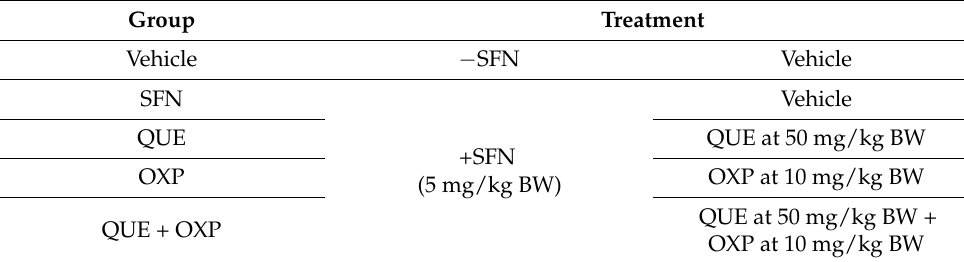
Table 1. Experimental groups for HCT116 cancer cell xenograft in BALB/c nude mice.